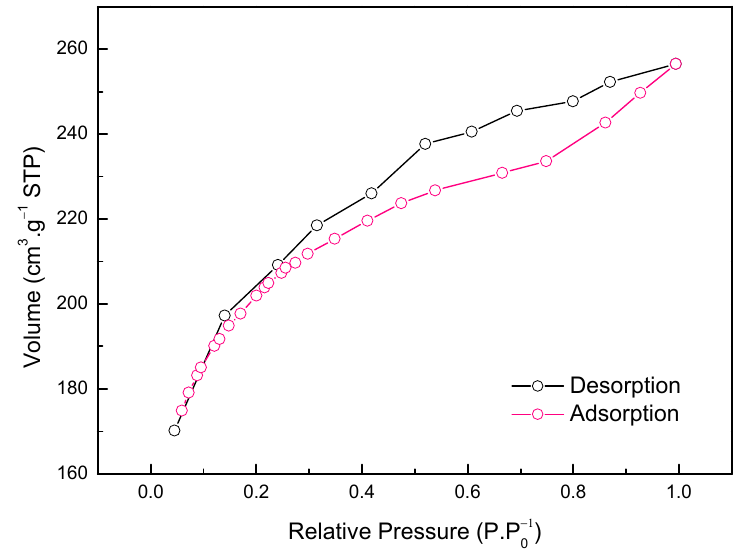
Figure 1. N 2 adsorption-desorption isotherm on ACOP sample. Table 2. Parameters used to obtain the activated carbon from olive